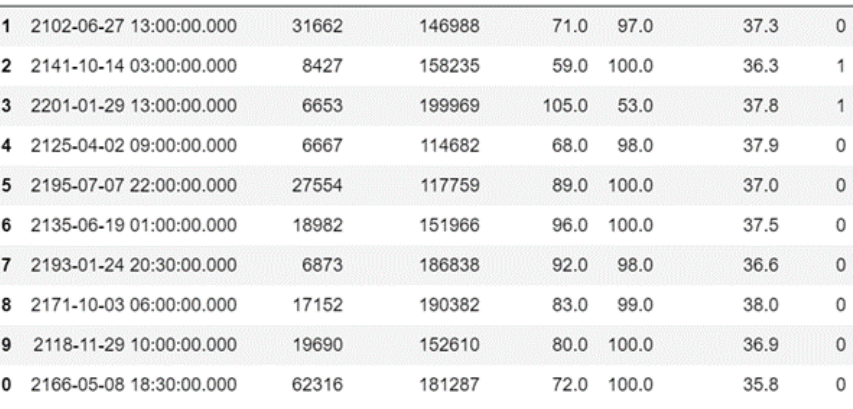
Figure 7. An instance of the labelled